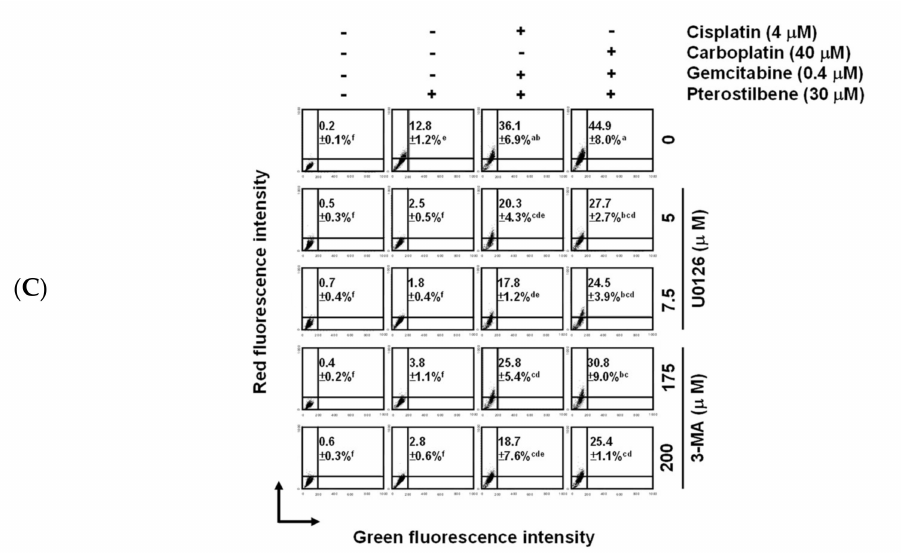
Figure 4. Pterostilbene changed the expression of autophagy-related proteins. ( A ) Expression of Atg5, Atg12-Atg5, and class III PI3K. ( B ) Expression of p-class I PI3K, p-mTOR, p-70S6K, p-MEK, and p-ERK. After treatment for 48 h, the total protein of T24 cells was subjected to Western blot analysis. Anti-Atg5, anti-class III PI3K, anti-p-class I PI3K, anti-p-mTOR, anti-p-70S6K, anti-p-MEK, and anti-p-ERK antibodies served as probes. β -actin served as a loading control. The intensity of each protein expression band was quantified through densitometry normalization to that of β -actin, with the control level arbitrarily set to 1. Results are representative of three independent experiments. ( C ) E ff ect of autophagy inhibitors on pterostilbene-induced autophagy. T24 cells were either pretreated with U0126 for 2 h prior to the addition of the indicated concentration of compounds for 48 h, or cotreated with 3-MA and the indicated concentration of compounds for 48 h. After treatment, the cells were stained with acridine orange before flow cytometry. The percentages in the figure indicate the proportion of cells (upper two quadrants) with AVOs staining of at least three independent experiments. Data are presented as means ± SEMs. Means with di ff erent superscript letters are significantly di ff erent, p <